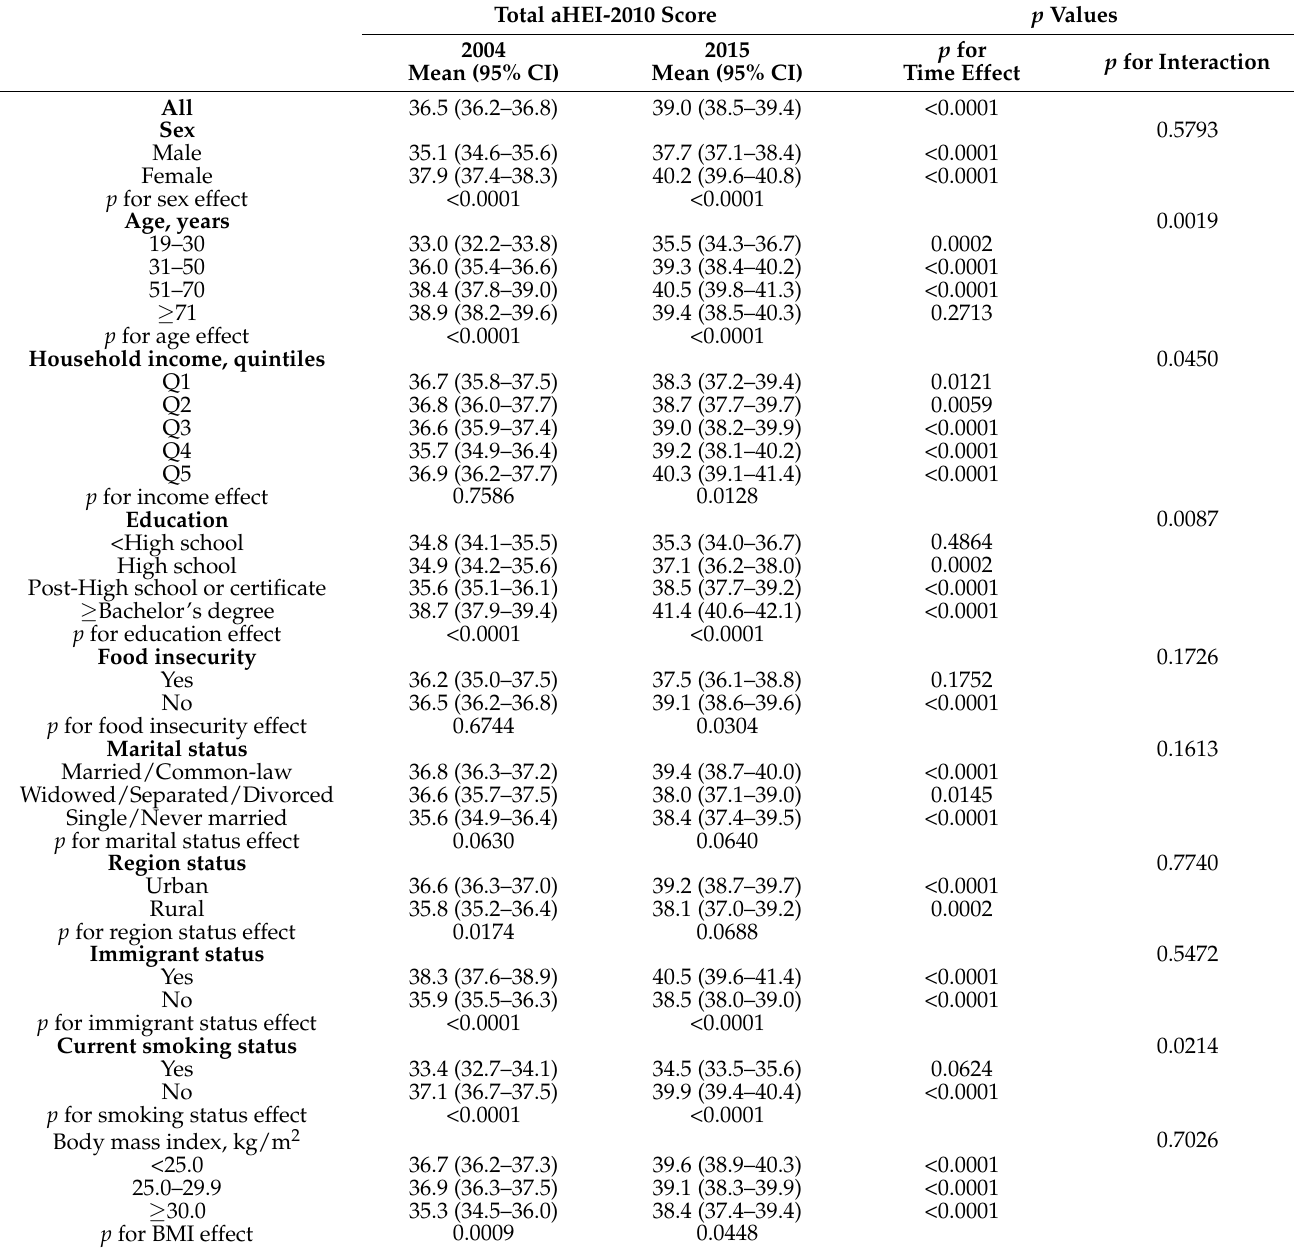
Table 3. Adjusted a mean total alternate Healthy Eating Index 2010 (aHEI-2010) score and 95% confidence intervals, by characteristics of adults from the Canadian Community Health Survey (CCHS)-Nutrition in 2004 and